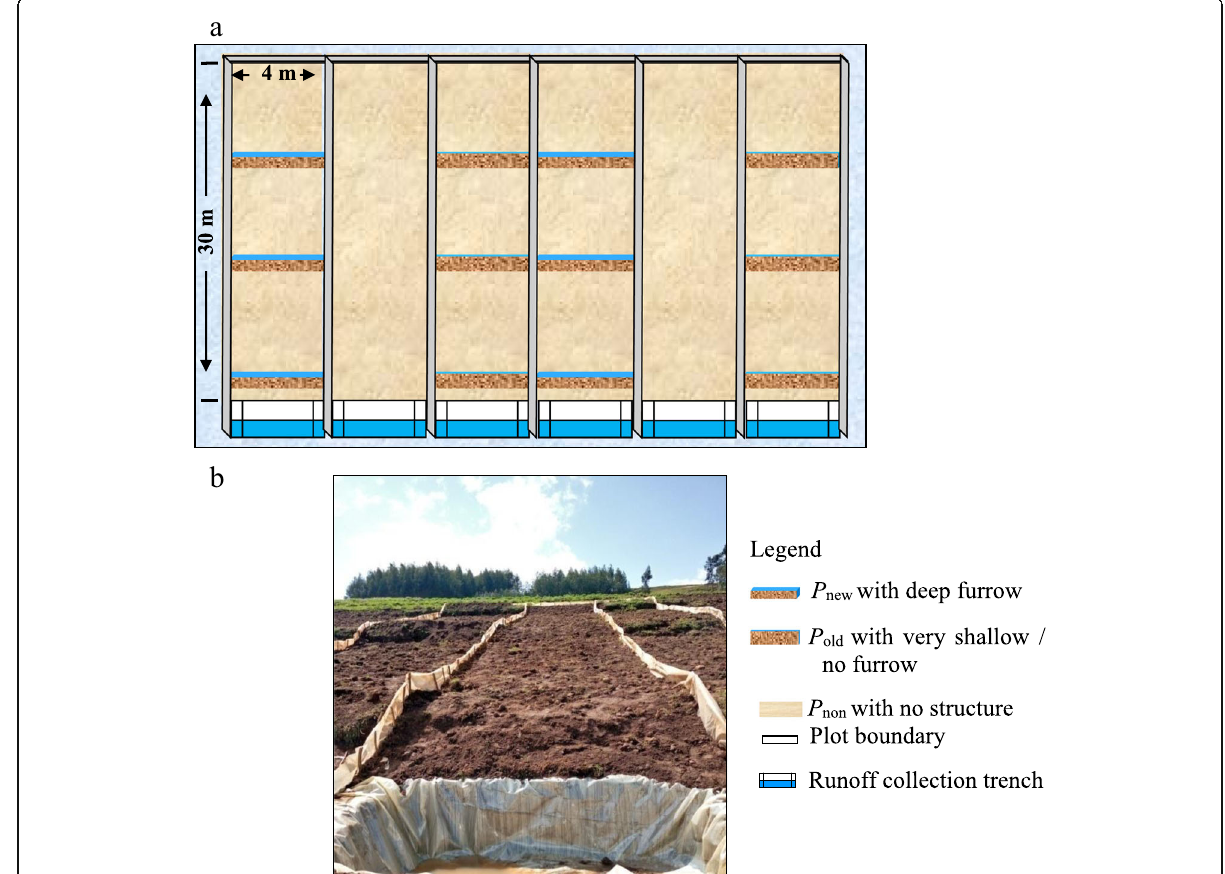
Fig. 2 A simplified representation of experimental erosion plots prepared for the study a schematic representation and b partial view of